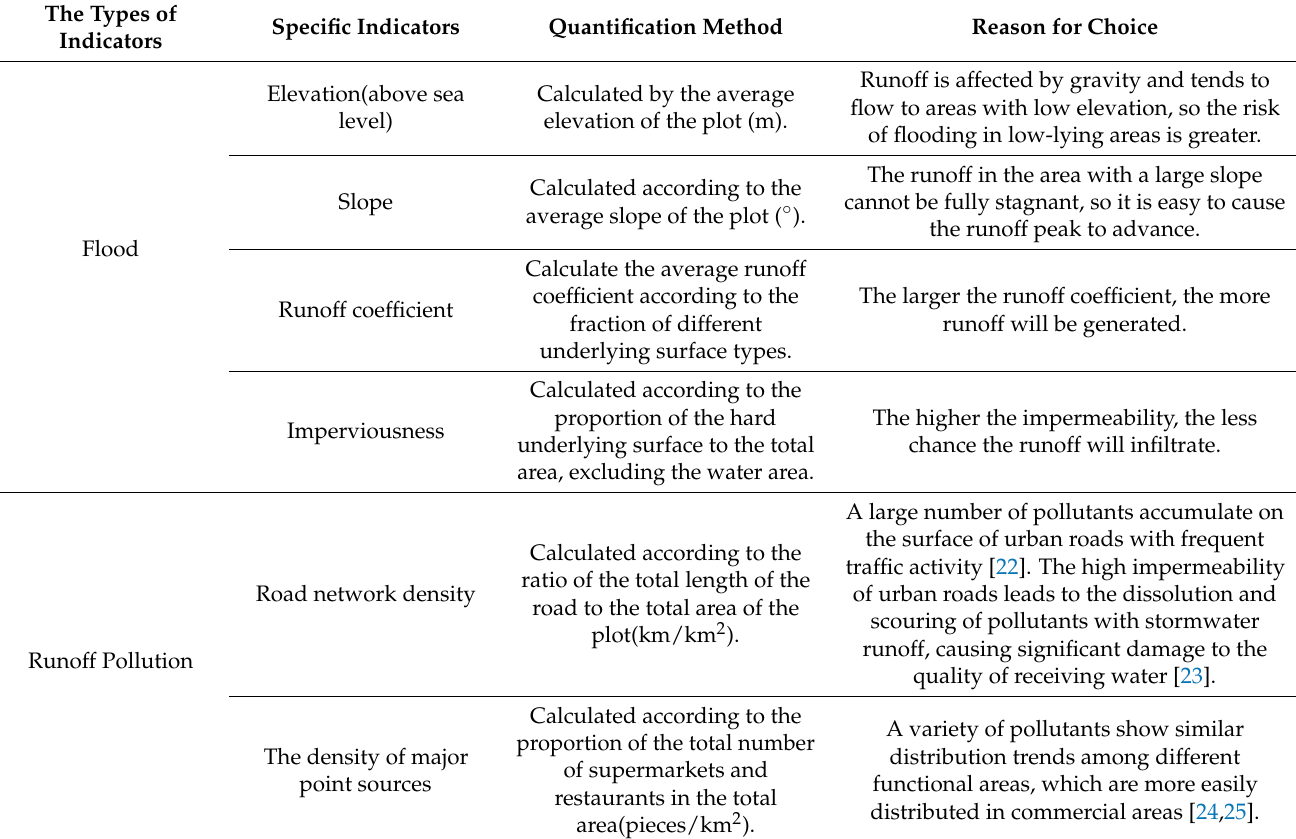
Table 1. The system of classification and evaluation of land